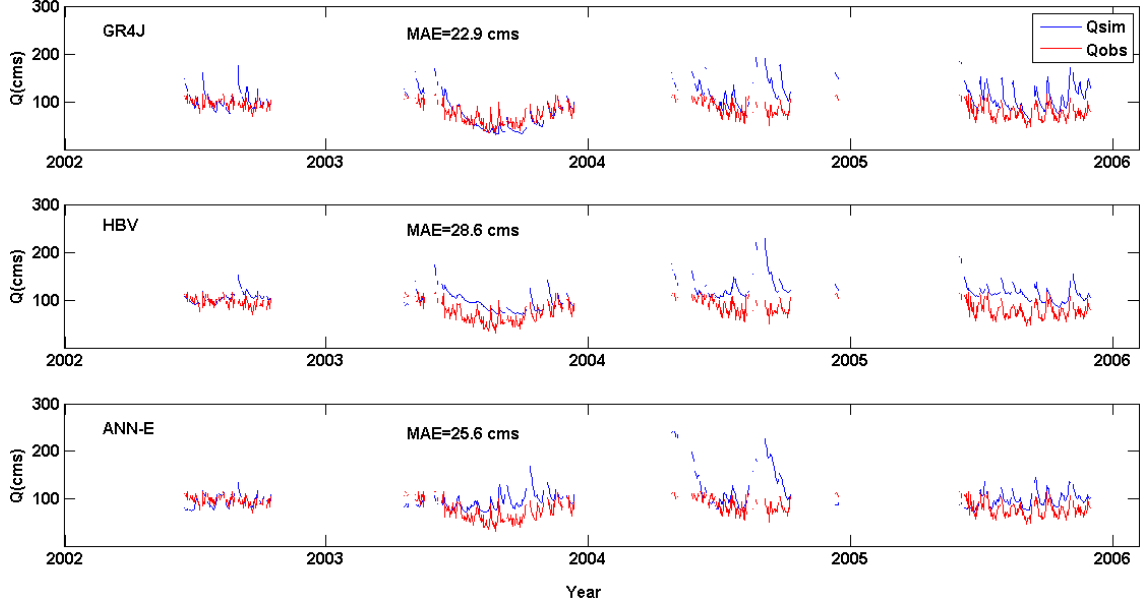
Figure 6. Benchmark reference forecasts using the three models (GR4J, HBV and ANN-E) using observed P and PET (i.e. perfect forecasts).